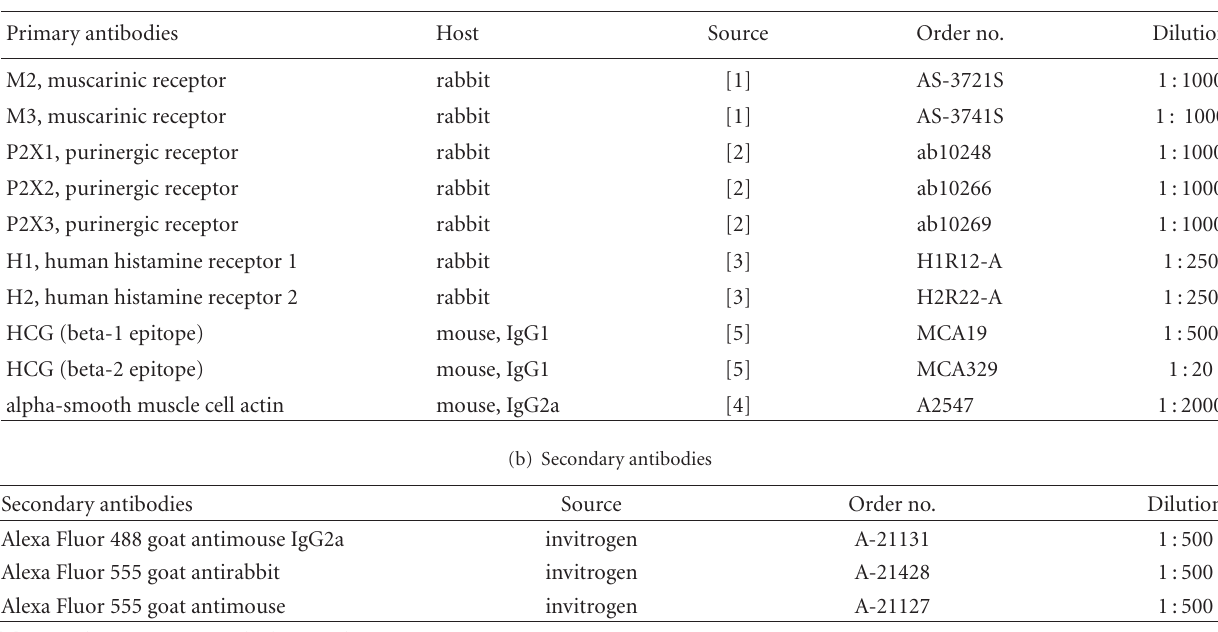
Table 1: Antibodies used in indirect confocal immunofluorescence.